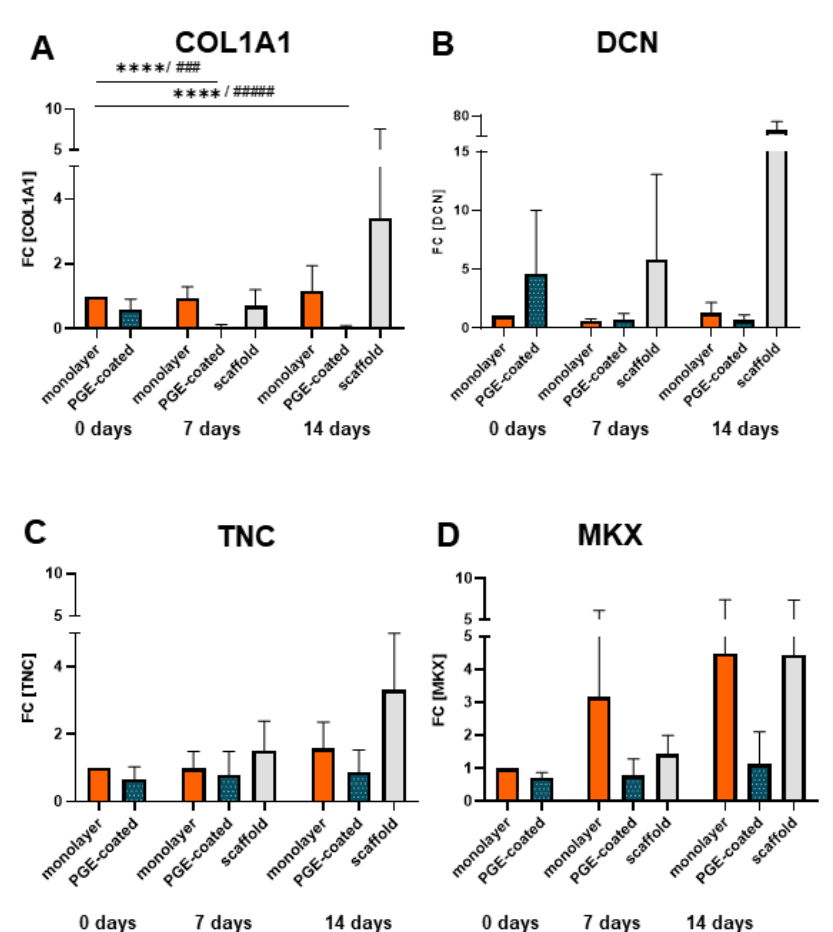
Figure 7. Gene expression of ligamentocytes cultured in monolayers, in sheets harvested from PGE-coated plates or in the scaffolds seeded using sheets after detachment (0 d), 7 and 14 d. ( A ) Type I collagen (COLA1), ( B ) decorin (DCN), ( C ) Tenascin C (TNC) and ( D ) Mohawk (MKX) gene expression in monolayer, poly(glycidyl ether) (PGE)-coated and uncoated plates after 0, 7 and 14 d, n = 4 independent experiments with ligamentocytes of four different donors. Statistic: One sample t-test, two-tailed (comparison with day 0 monolayer) (*), paired one-way ANOVA (comparison between the groups) (#), Grubbs test ( α = 0.05). p values: ### <0.001, ****/#### <0.0001 ( A – D ).